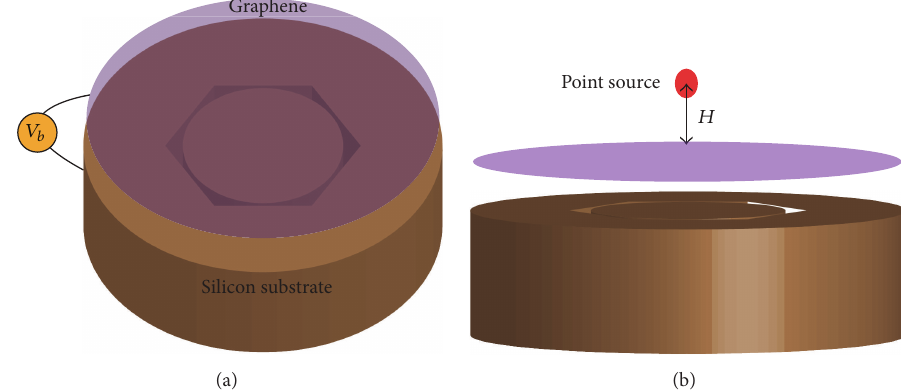
Figure 3: (a) Sketch of our proposed one-atom-thick wave splitter, which consists of a single sheet of graphene with inhomogeneous conductivity or permittivity distributions. (b) A point source on top of the graphene layer is used to excite circular SPP waves. The distance between the source and the wave splitter is 𝐻 =